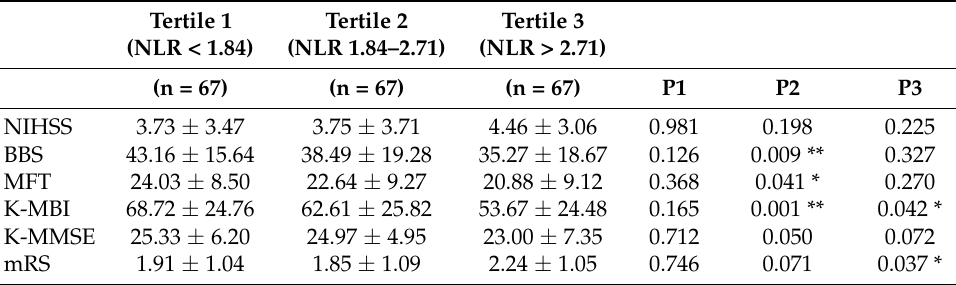
Table 3. Comparison of stroke severity and functional outcomes in patients categorized by NLR tertiles.